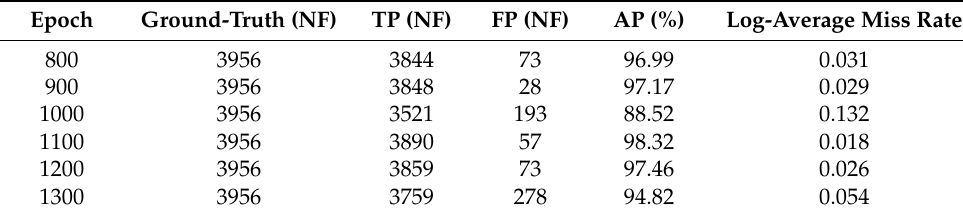
Table 11. The results of various indicators in different epochs.